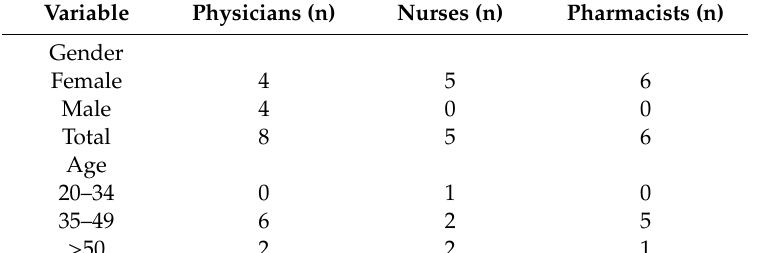
Table 2. Characteristics of the interviewed healthcare professionals ( n = 19) in the focus groups ( n = 5).